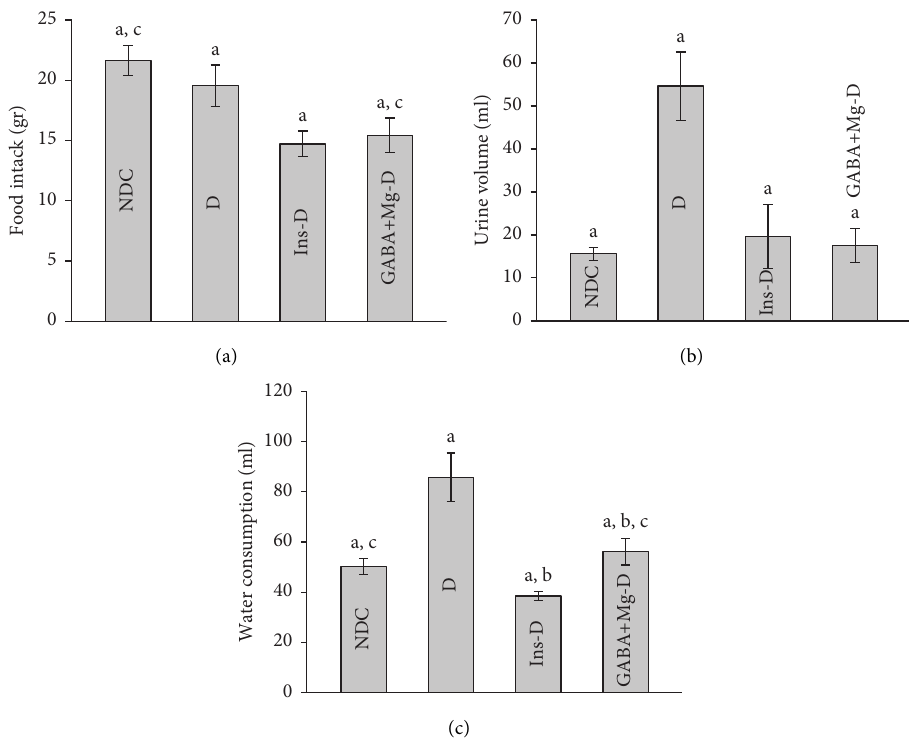
Figure 4: Comparison of food intake (a), urine volume (b), and water consumption. (c) In the nondiabetic control group (NDC) fed with a normal diet, the chronic diabetic group received high-fat diet and 35mg/Kg STZ (D), diabetic animals treated with insulin (2.5U/Kg two times per day) (Ins-D), and diabetic animals treated with GABA (1.5gr/kg) +MgSO 4 (10g/l add in drinking water) (GABA +Mg-D) (10 rats in each group; data are expressed as mean ± SEM). (a) Significant difference between D and other groups ( P < 0.001). (b) Significant difference between GABA+Mg-D and Ins-D group ( P < 0.01). (c) Significant difference between NDC group and GABA+Mg-D ( P <